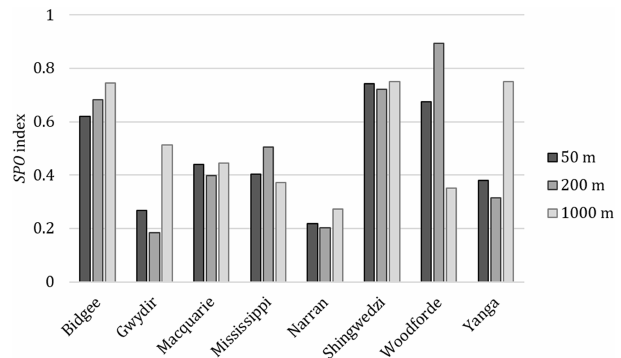
Figure 4. Index of spatial organisation of surface conditions (SPO) for the eight floodplains at each of the three window